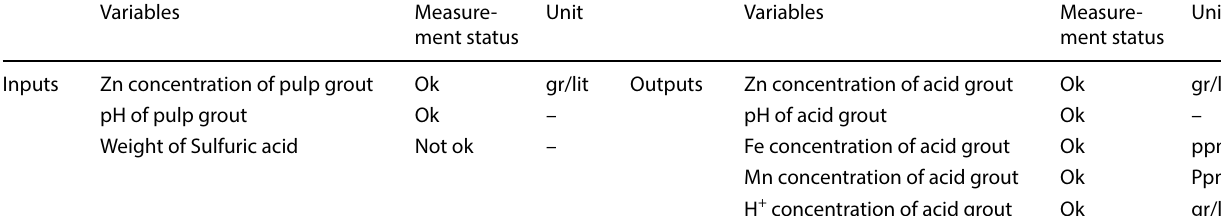
Fig. 4 Data mining